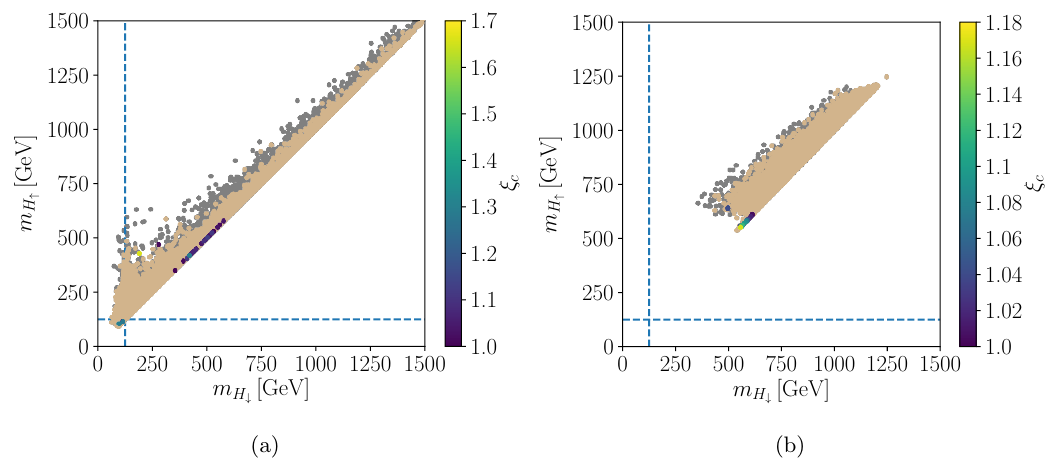
Figure 2 . C2HDM: the mass m H all parameter points passing the experimental and theoretical checks of ScannerS . The color code denotes the strength of the phase transition (cid:24) c for (cid:24) c included. The blue dashed lines indicate the SM Higgs mass value of m h